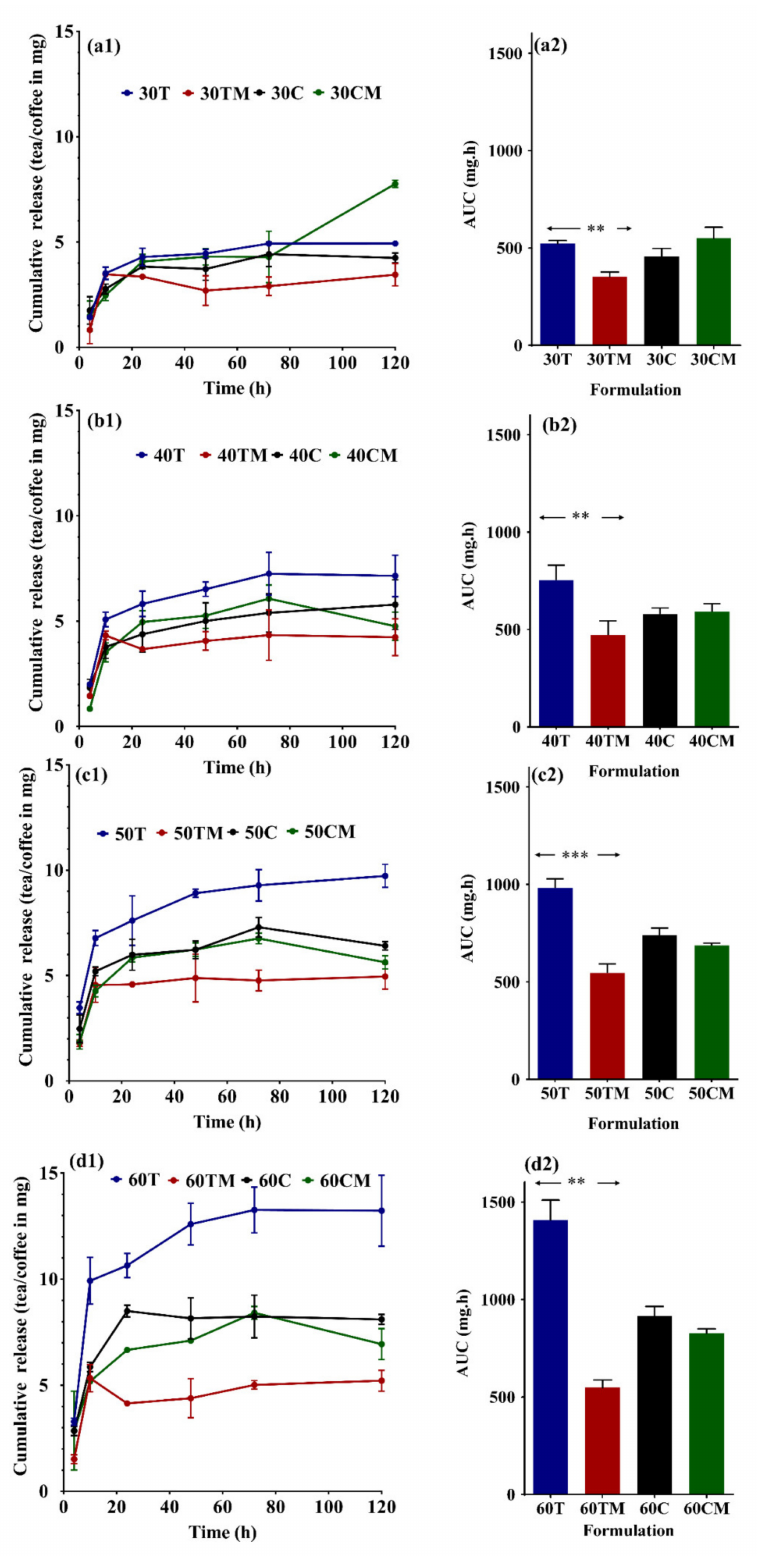
Figure 5. ( a1 – d1 ): Cumulative tea release over time from the different hydrogels for 120 h for different tea and coffee hydrogel formulations. ( a2 – d2 ): Area under the curve from the individual curve of cumulative tea release for 120 h the different hydrogels. The results from three independent experiments (3 replicates in each experiment) are presented as mean ± standard deviation (SD). Unpaired t -test with Welch’s correction was applied, ** indicate p < 0.01, *** indicate p <